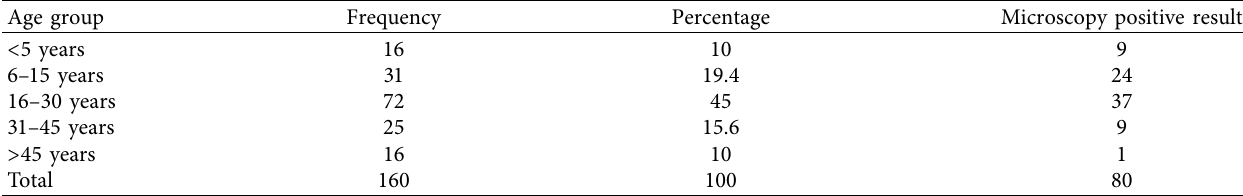
Table 1: Age group distribution of the study participants, Arba Minch, 2016.